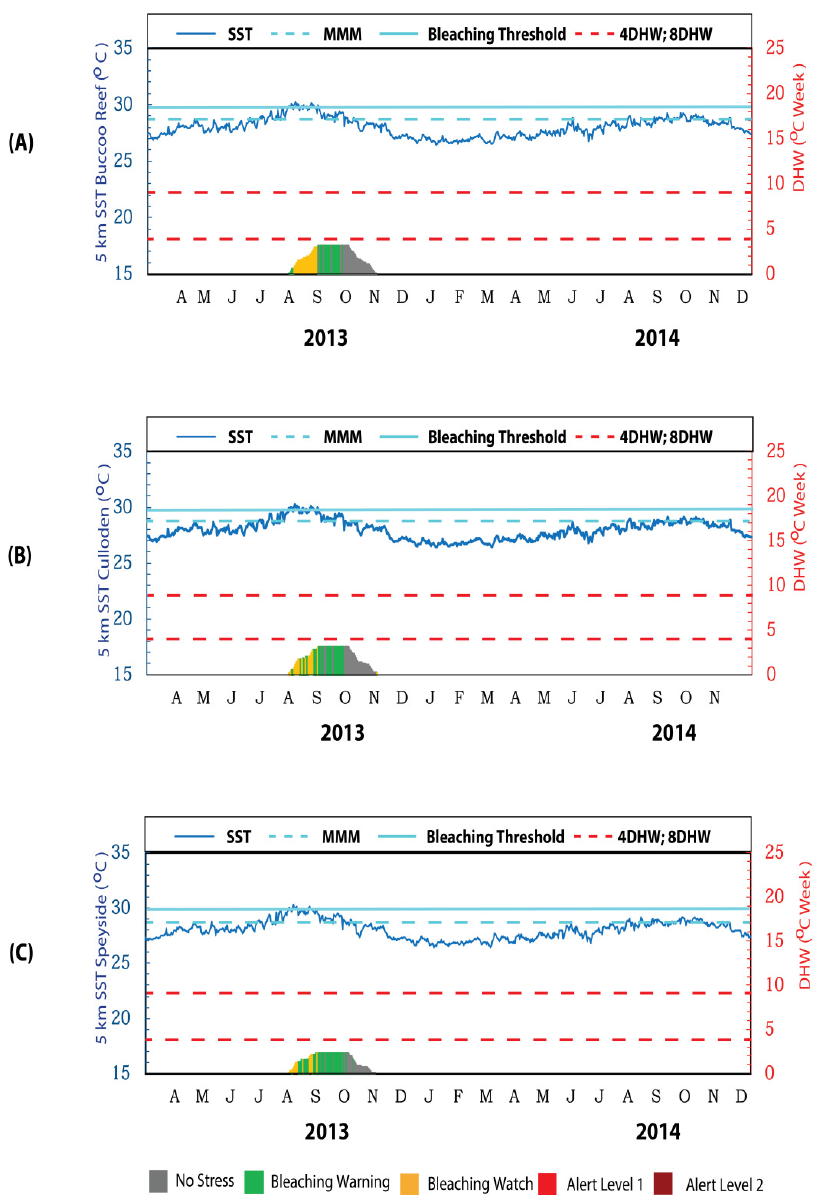
Figure 9. Daily 5 km sea surface temperature and Degree Heating Weeks (DHW) for 2013 and 2014. These products represent the three reefs sites in Tobago: ( A ) Buccoo Reef; ( B ) Culloden; and ( C ) Speyside.